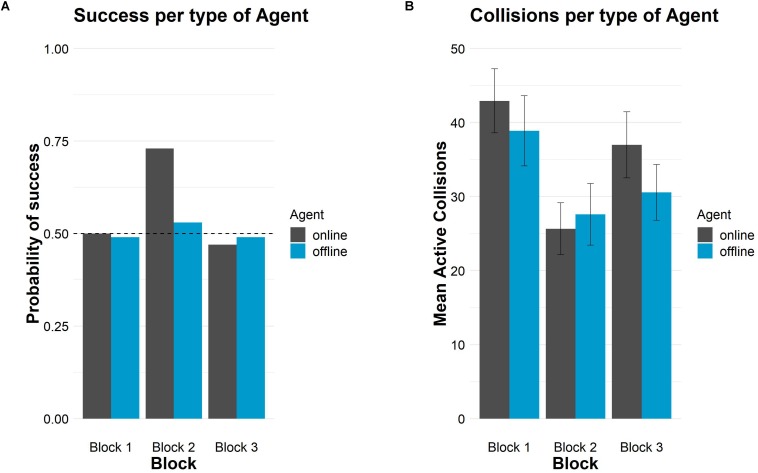
Successes and crossings per type of agent and block in Study 2. (A) Probability of success in each block per type of agent. The horizontal dashed line represents chance level (50%). (B) Mean number of crossings in each block per type of agent. Error bars depict 95% confidence intervals.